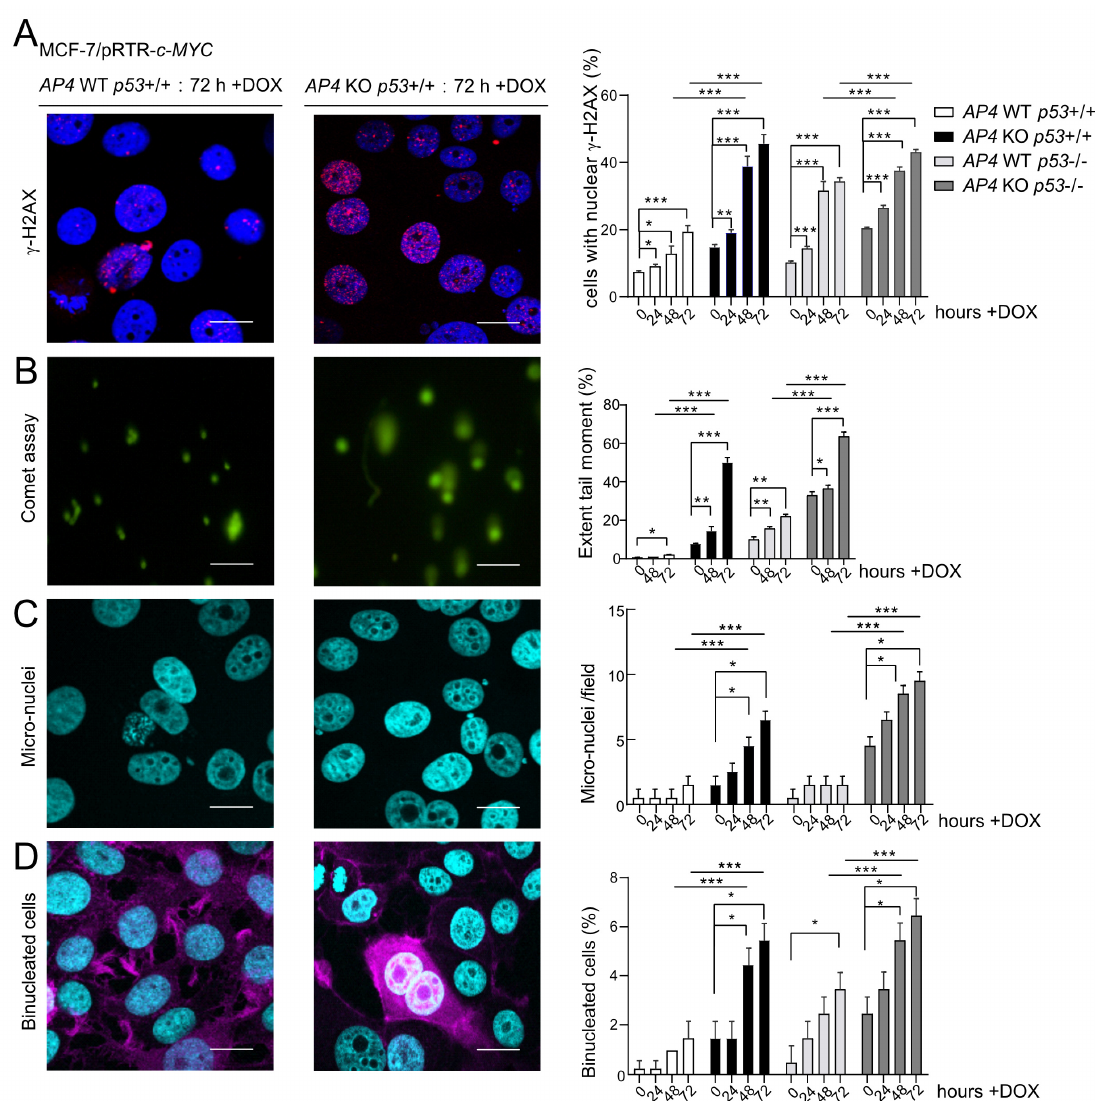
Figure 4. Effects of AP4 - and/or p53 -deficiency on basal and c-MYC-induced DNA damage. ( A – D ) Activation of c-MYC in the indicated cells by treatment with DOX for the indicated periods. ( A ) Evaluation of DNA damage by detection of γ H2AX foci in five microscopic fields with 150 cells in total. Scale bars: 20 μ m. ( B ) Evaluation of unrepaired DNA damage by Comet assays in ten microscopic fields with 150 cells in total. Scale bars: 10 μ m. ( C ) Quantification of micronuclei by DAPI staining in five microscopic fields with 150 cells in total. Scale bars: 20 μ m. ( D ) Detection of bi-nucleated cells by DAPI and F-actin staining in ten microscopic fields with 300 cells in total. Scale bars: 20 μ m. ( A – D ) Representative images of all time points and genotypes analyzed are provided in Figures S2–S5. ( A – D ) Results are presented as the mean +/ − SD with *: p < 0.05, **: p < 0.01, ***: p < 0.001.